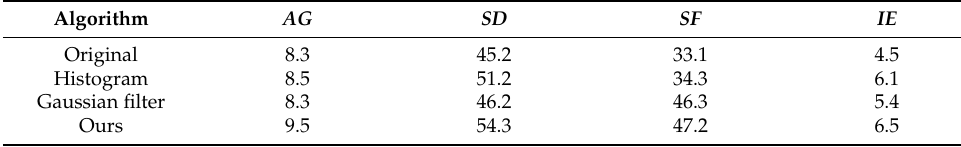
Table 3. Multiple coastlines image quality.